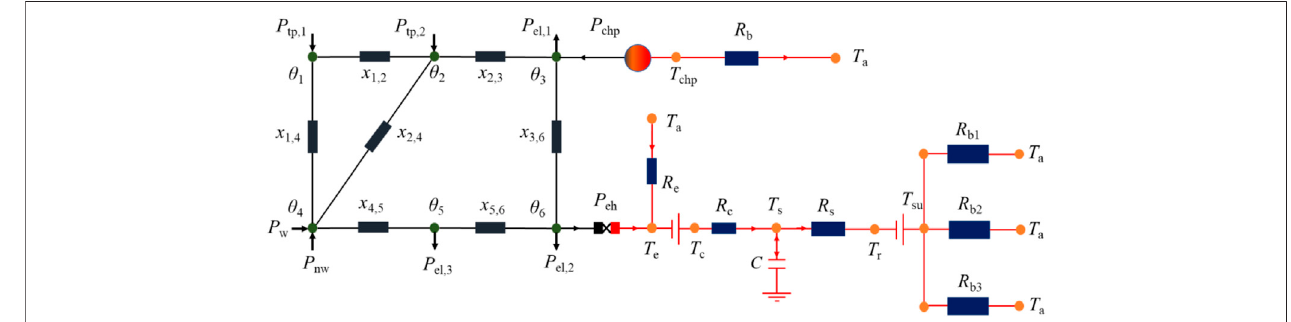
FIGURE 4 | Power fl ow model of the IETEs with the heat pump and thermal storage